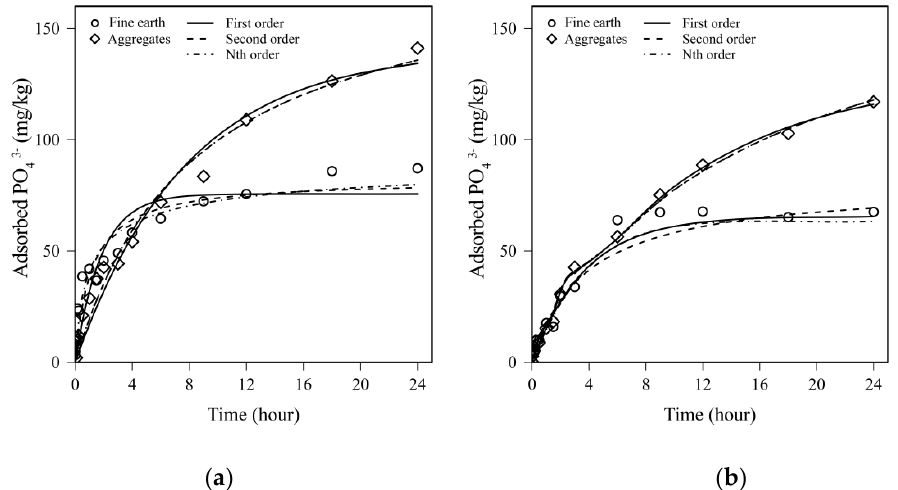
Figure 4. Phosphate sorption kinetic data and optimized model equations for aggregates and fine earth for the ( a ) topsoil and ( b ) subsoil (initial phosphate concentration of 20 mg L − 1